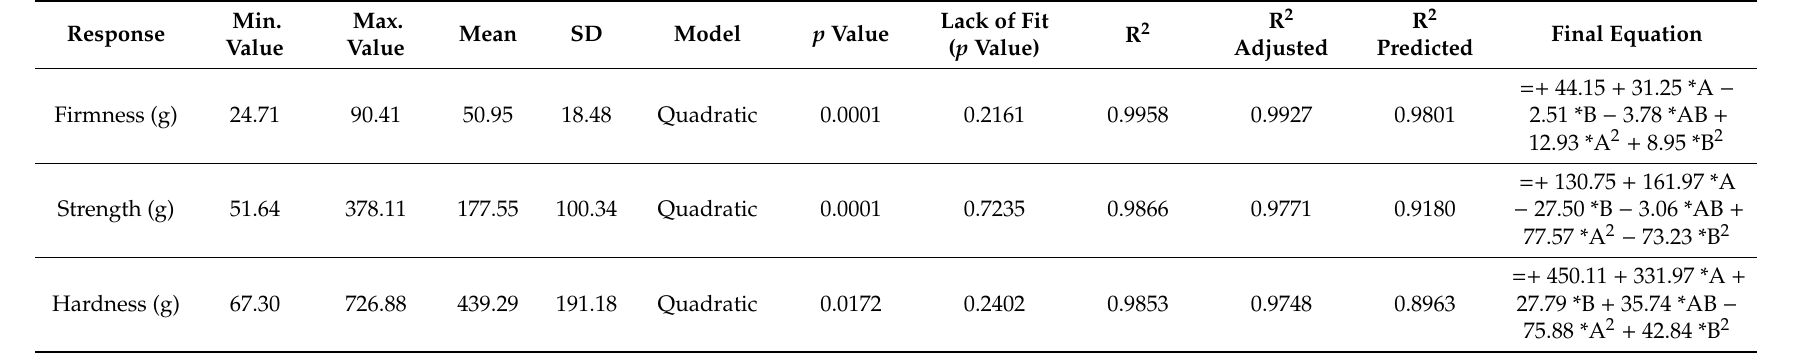
Table 2. Statistical data and final equations of responses